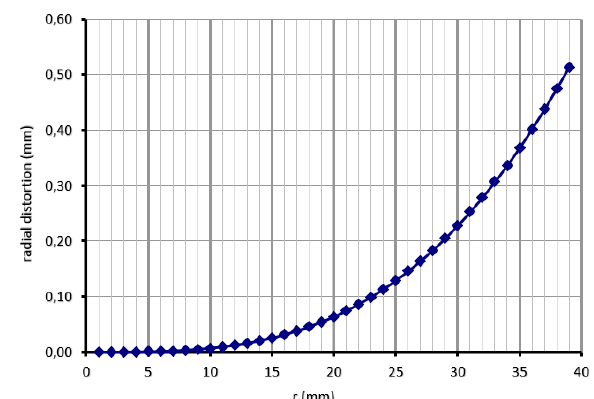
Figure 8. Radial distortion for 80 mm